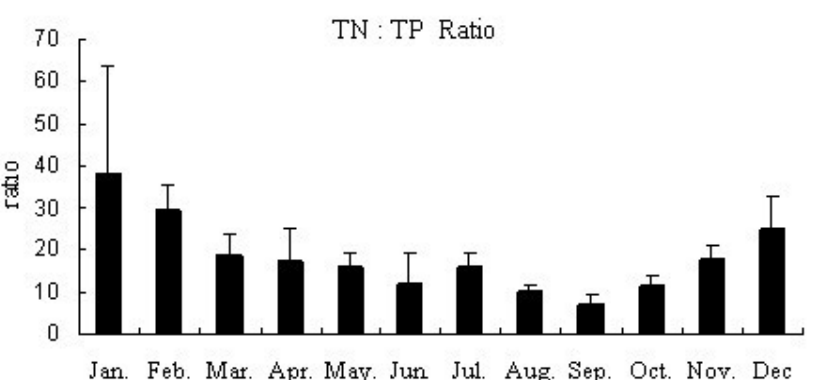
FIGURE 6. Seasonal variations of TN:TP ratio in Gonghu Bay 2008 (means ± standard deviation).